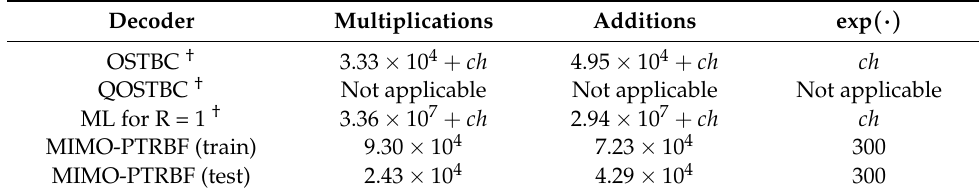
Table 4. Computational complexities for M T = M R = 8 and 2 bits/s/Hz.